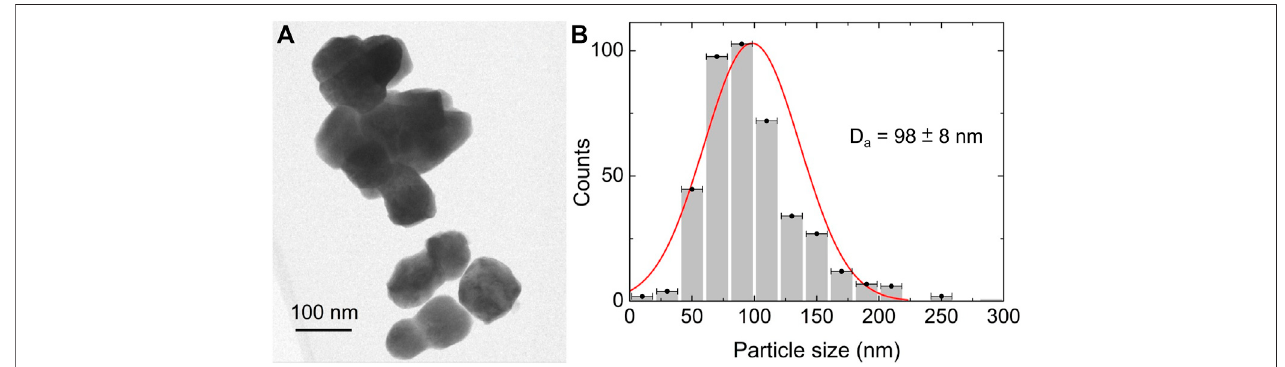
FIGURE6|(A) The(S)TEM image ofBiFeO 3 prepared bythecombinedmechanochemical − thermal route. (B) Theparticlesize distribution inthematerial results in the average particle size D a (cid:1) 98 ± 8 nm. The error bars showing the uncertainty in the particle size analysis are indicated.